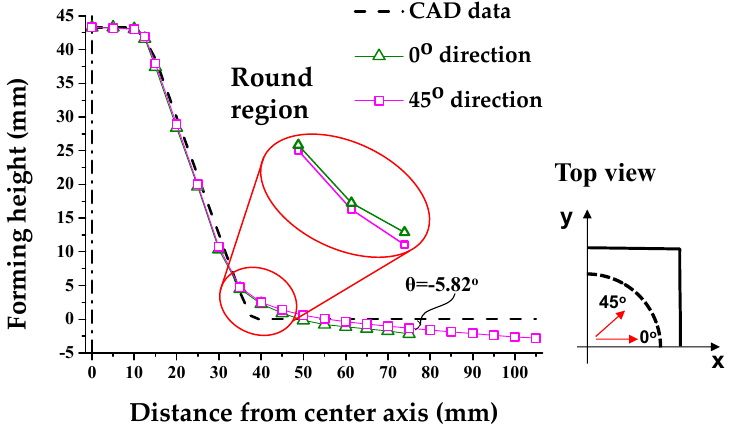
Figure 8. Comparison of the cross-sectional shape after 1st SPIF.